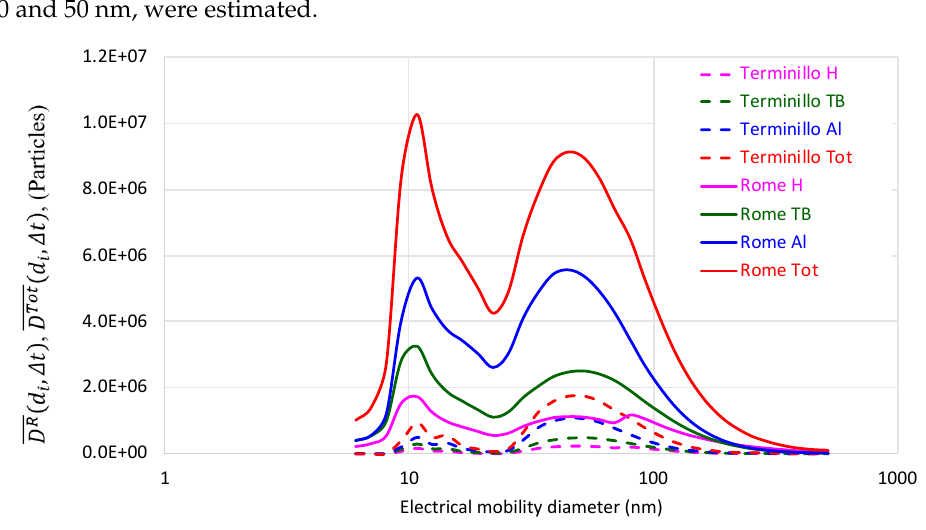
Figure 4. Average regional ( D R ( d i , ∆ t ) ) and total D Tot ( d i , ∆ t ) ) size number dose distributions in the 07:00–08:00 1h-time interval in downtown Rome and in the Terminillo area.